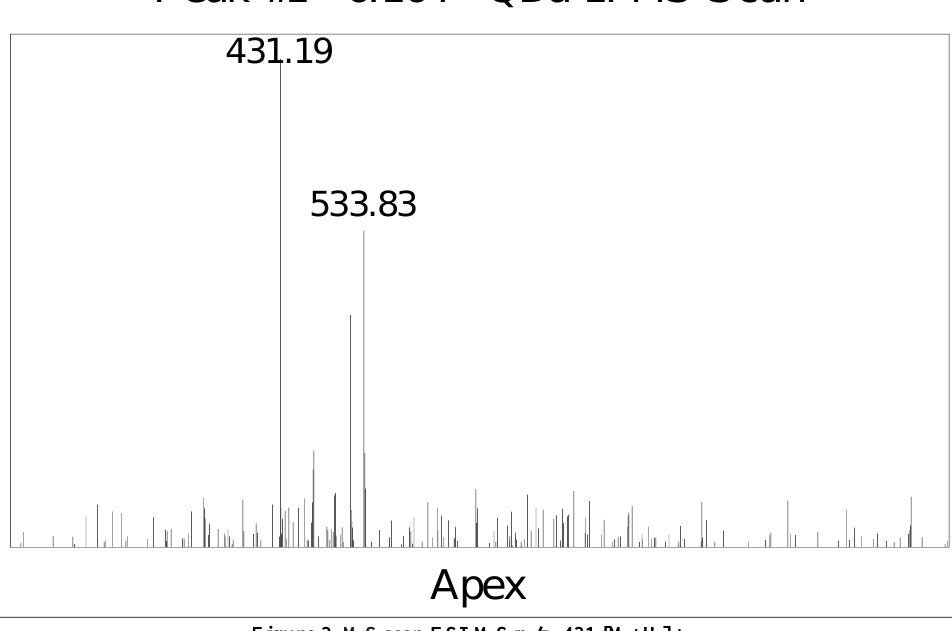
Figure 3. MS scan ESI-MS m/z: 431 [M+H] +